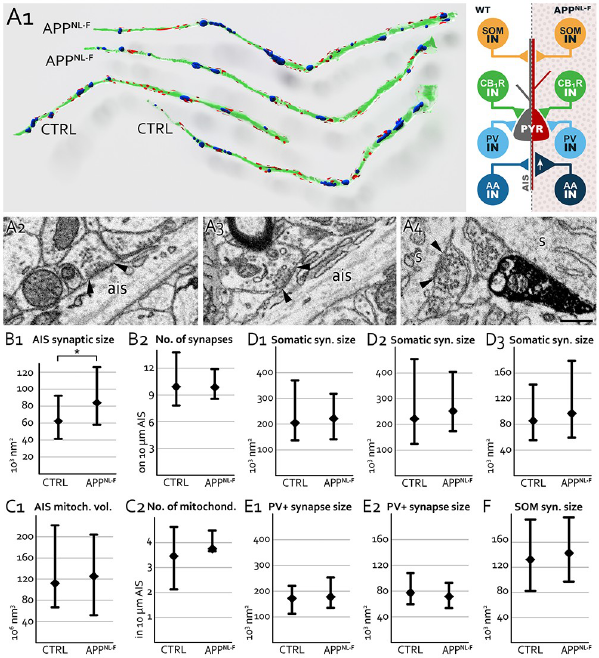
Fig 6. 3D morphology of hippocampal inhibitory synapses in 18-month-old APP NL-F mice. A: BF-SEM 3D reconstruction of CA1 pyramidal cell axon initial segments (AISs) from APPNL-F and WT (CTRL) animals. Synapses (red) on the axonal membrane (green) and mitochondria (blue) were also reconstructed and counted. On the right hand side, schematic representation of the results show that while synaptic area of SOM-positive INs (SOM IN), CB1R-positive basket cells (CB1R IN), PV-positive basket cells (pale blue PV IN) do not change, synaptic area of PV- positive axo-axonic cells (AA IN) enlarged significantly by about 35% (A1). Representative BF-SEM images show synapses (black arrows at synaptic edges) formed by axo-axonic terminals on pyramidal cell axon initial segments (ais) of APP NL-F (A2) and WT (A3) mice. In addition, CB 1 R-negative somatic terminals on pyramidal cells (s) in CA1 (dark precipitation indicates CB1R-staining, A4). B: Significant increase was found in the size of pyramidal cell AIS synapses in three pairs (pooled data) of APP NL-F and WT (CTRL, B1) mice, while the linear density of their synapses on AISs remained unchanged (B2). C: No changes in the size (C1) or density (C2) of pyramidal cell mitochondria in the AISs as detected in three pairs (pooled data) of WT (CTRL) and APP NL-F mice. D: Sizes of synapses on pyramidal cells somata did not change in three pairs of WT and APP NL-F mice (D1-3). E: Sizes of synapses established by PV-positive (CB 1 R-negative) INs on pyramidal cells somata were not different in two pairs of 18-month-old WT and APP NL-F mice (E1, E2). F: Sizes of synapses established by SOM-positive INs on pyramidal cells dendrites were not different in two pairs (pooled data) of 18-month-old WT and APP NL-F